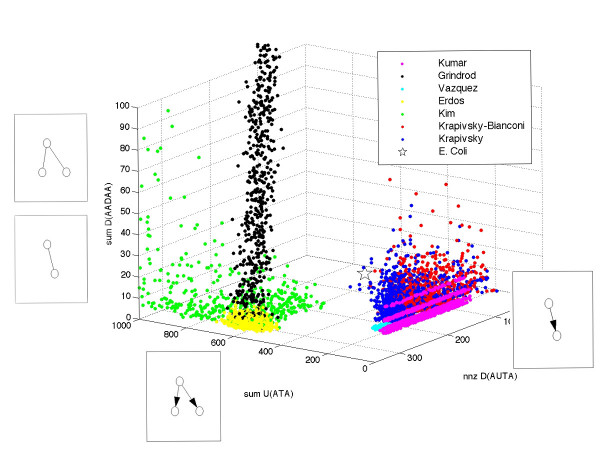
Distributions of the E. coli training data in word space. The training data for E. coli for seven directed models is visualized in a 3-dimensional subspace of word space. The three chosen words were found to be most discriminative according to a word ranking method. Every color is associated with a different model. The point which is occupied by E. coli is also indicated. The axis correspond to words which can be associated with sets of subgraphs. If a network has a non-zero word value it must possess at least one of these subgraphs.